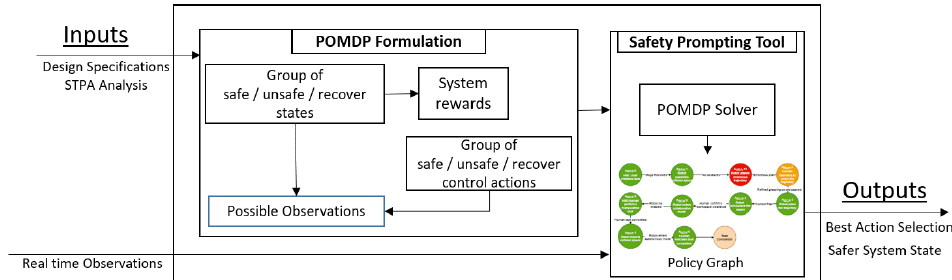
Figure 1. The flowchart of the proposed